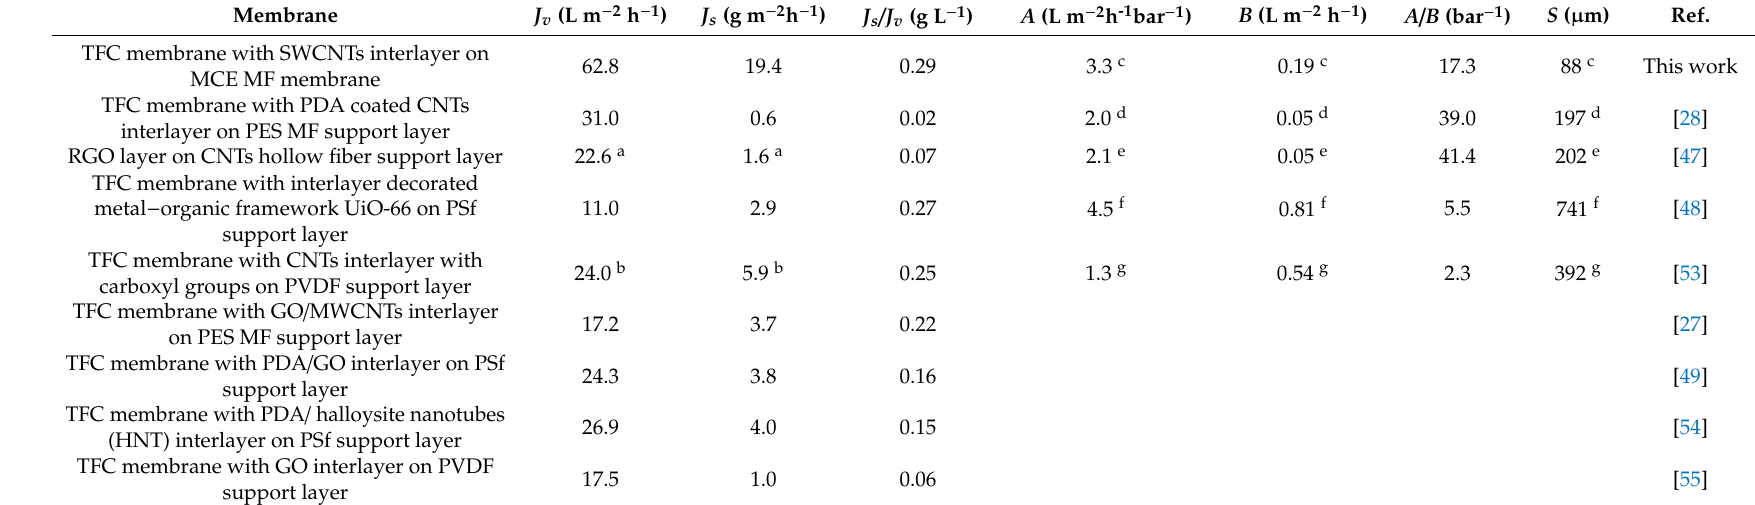
Table 1. Summarizes the FO performance and intrinsic separation properties of FO membranes with interlayers reported in the recent literature.